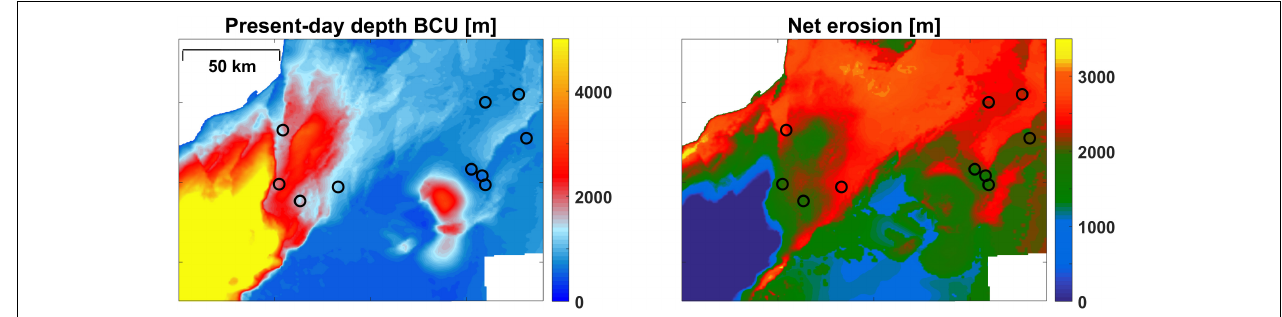
FIGURE 6 | Left: Present-day Base Cretaceous Unconformity (BCU) horizon (which is close to the Top Stø Fm sandstone horizon) in the selected area in the southern Barents Sea (offshore Norway), and selected well locations used in the calibration study (black circles). Right: Estimated net erosion map derived from seismic velocities relative to a normal compaction trend (Adapted from Avseth et al., 2020b).